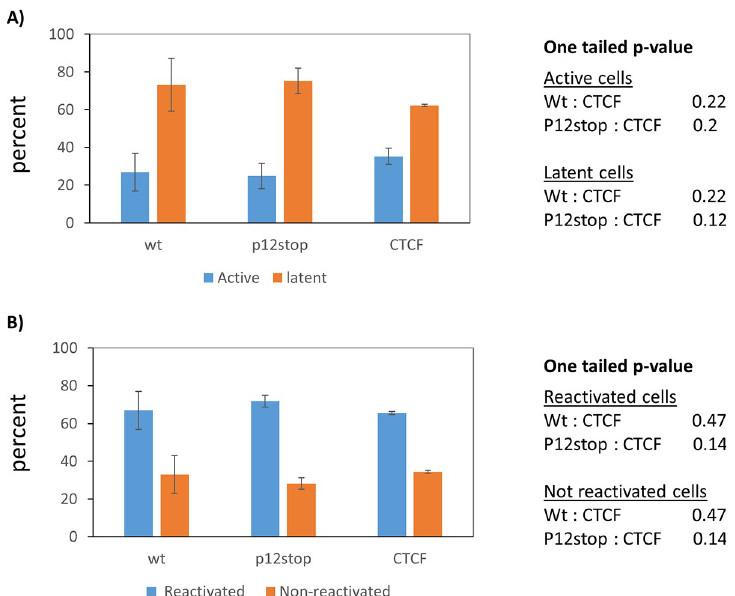
Fig 7. Latency establishment and reactivation of HTLV-1 does not depend on CTCF binding. JET cells were infected by coculturing with lethally γ -irradiated 729B/HTLV-1, 729B/HTLV-1p12stop or 729B/HTLV-1 Δ CTCF and single infected cell clones were selected via limiting dilution. RFP (the indicator of Tax expression) positive or negative cells were examined and percentages of latent (RFP negative) and active (RFP positive) HTLV-1 infected cells are shown in panel A. RFP negative cells were activated with PMA/Ionomycin for 48hr. RFP positive and negative cells were counted and the result from three experiments is presented with standard errors in panel